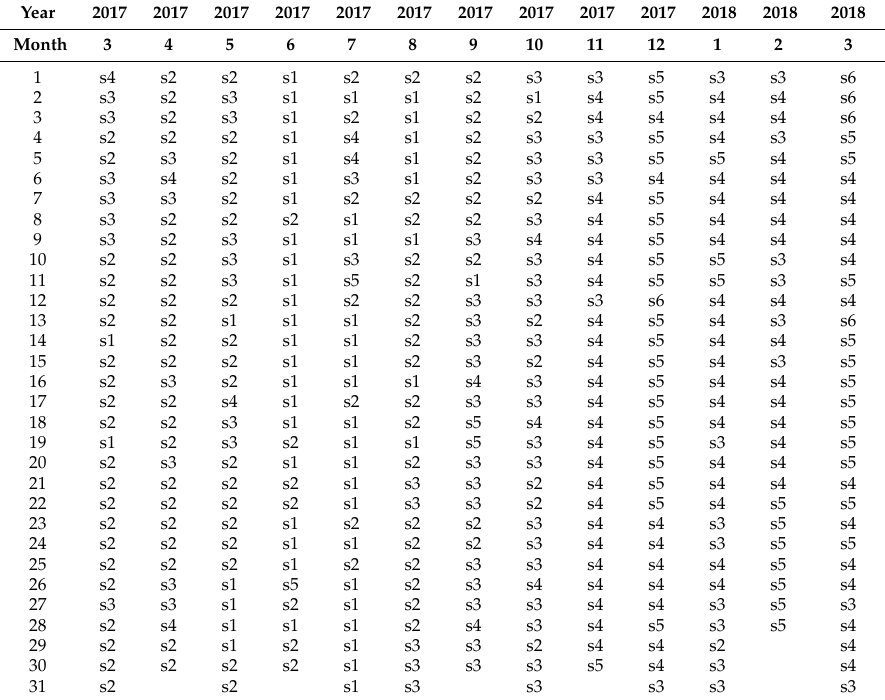
Table 1. Fuzzy time series of monitored series (six fuzzy